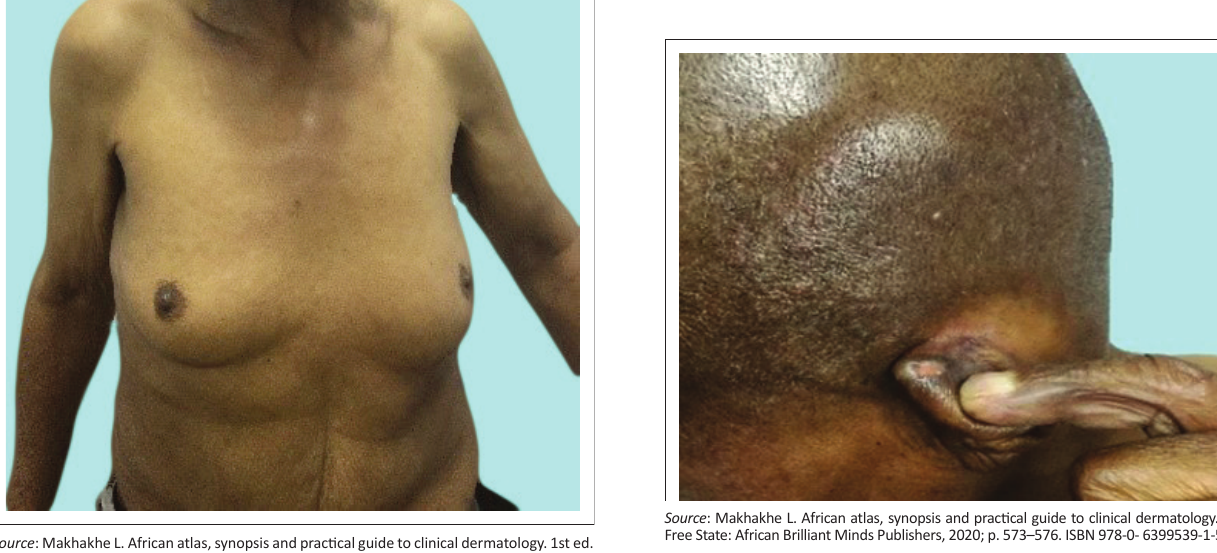
FIGURE 3: Gynecomastia secondary to testicular infiltration by the